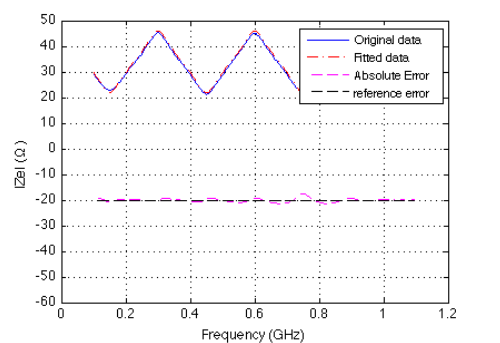
Figure 5. Impedance seen from the input of the line for a -20 dB error constraint.